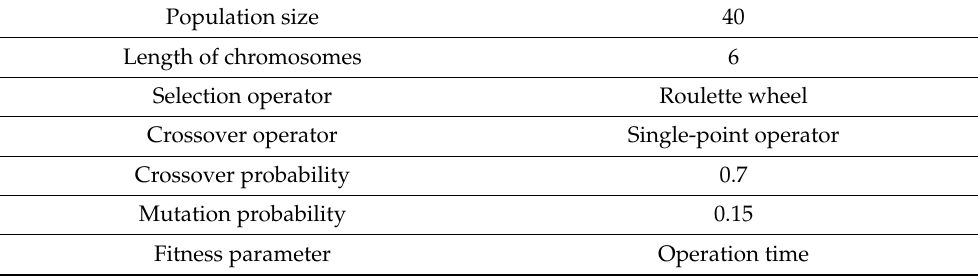
Table 3. Parameter configuration of